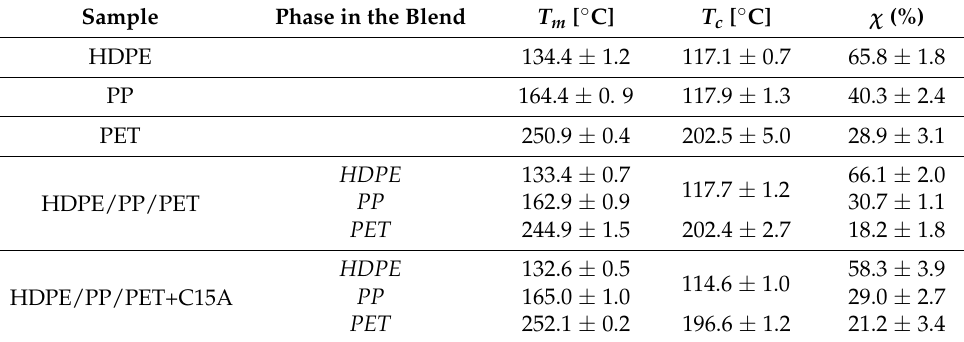
Table 5. Melting and crystallization temperature and degree of crystallinity for the pure polymers and the polymer phases of the blends.